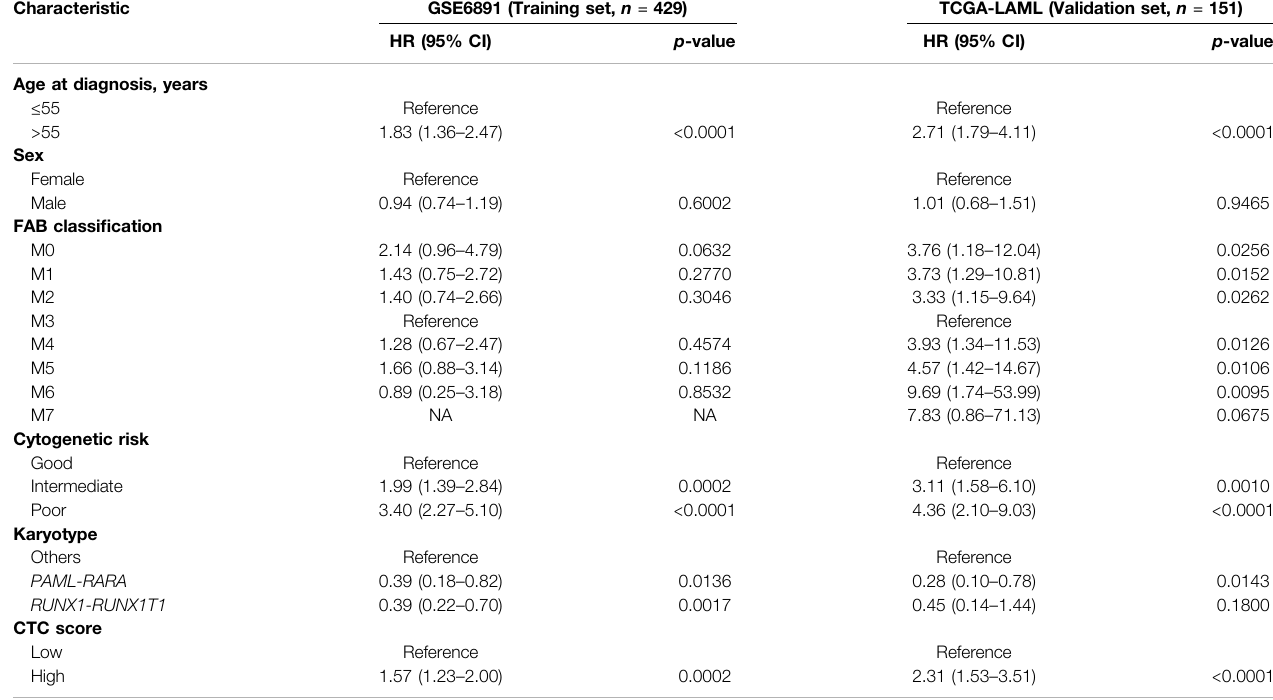
TABLE 2 | Univariable Cox regression with overall survival as the outcome.